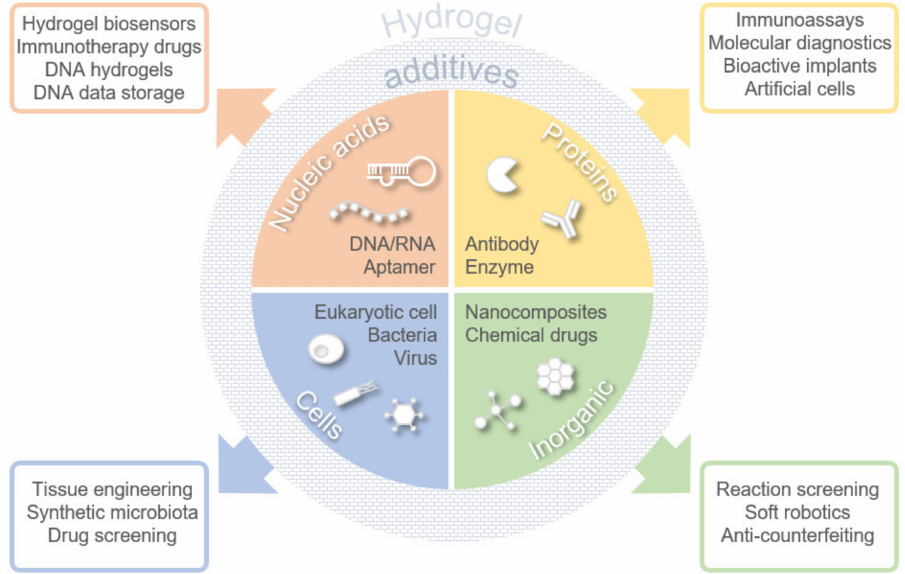
Figure 1. Types of hydrogel additives and their functional